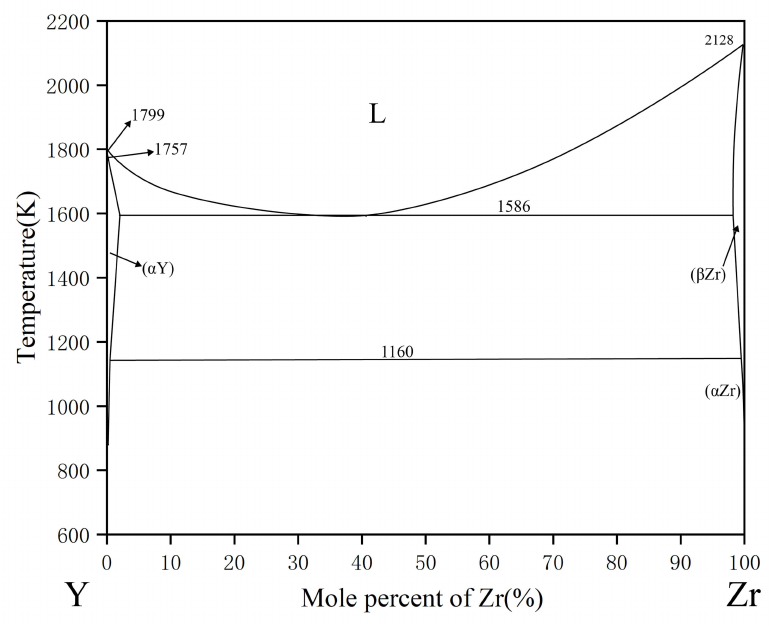
Figure 3. The calculated Y-Zr phase diagram based on the work of Bu et al. [38]. Research on the phase relationships and ternary compounds of Fe-Zr-Y ternary sys- tems was relatively limited. In 1986, by combining three related binary phase diagrams, Harchenko et al. [39] measured the 1070K isothermal section of the Fe-Zr-Y ternary system for the first time, but no ternary compounds were discovered, as shown in Figure 4. In 1989, Jifan et al. reported Fe 9 Zr 2 Y phase with ThMn 12 structure [40]. At the same time, Itoh et al. also found Fe 2.9 Zr 0.5 Y 0.5 phase of Orthorhombic type [41]. The binary and ternary phases, the crystal structure and lattice parameters that were previously reported are listed in Table 1.